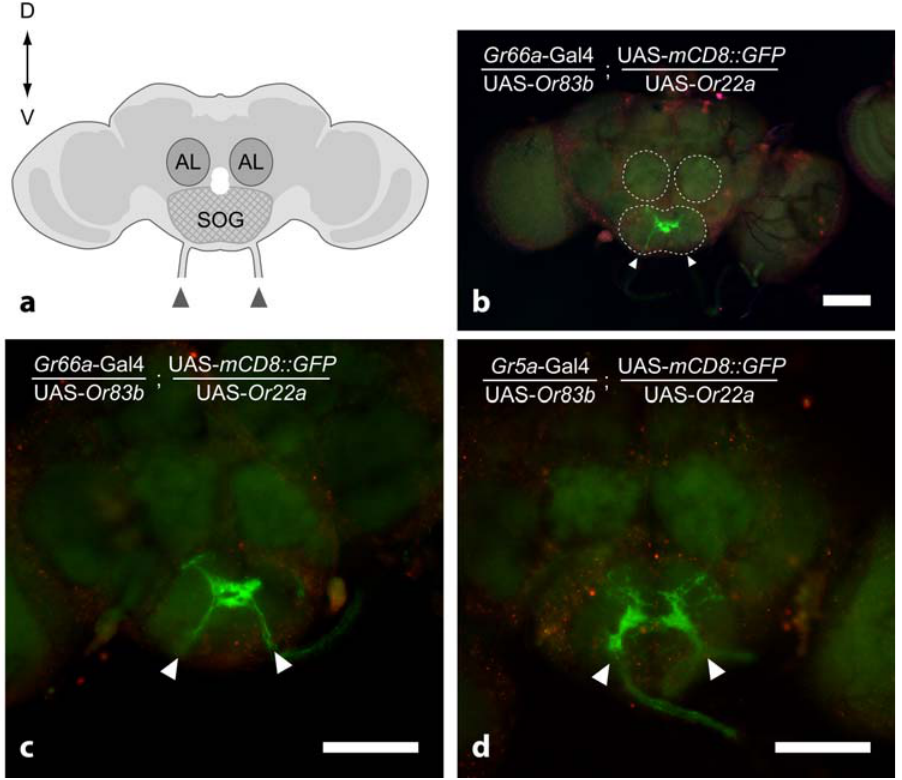
Figure 4. Ectopic expression of Or22a and Or83b in GRNs does not alter the projection pattern of the GRNs. a. Schematic diagram of the frontal view of a fly brain. Dorsal is to the top. Arrow heads indicate incoming fibers of GRNs in the proboscis. AL=antennal lobe, SOG=suboesophageal ganglion. b. Whole-mount of a fly brain, showing projection of Gr66a -positive GRNs that co-express Or22a and Or83b in the SOG. Gr66a -GRNs were labeled by mCD8::GFP. Areas surrounded by dotted line are ALs and SOG. This figure and the followings are single pictures from the microscope. The red signal is used here to obtain the outlines of the brain. c. Close-up view of the SOG and ALs in b. d. Projection of Gr5a - GRNs expressing Or22a and Or83b in the SOG. Both type of GRNs ( Gr66a and Gr5a ) were not affected in their projection patterns by co-expressing the Ors in their projection patterns. Scale bars in b, c and d=50 m m.